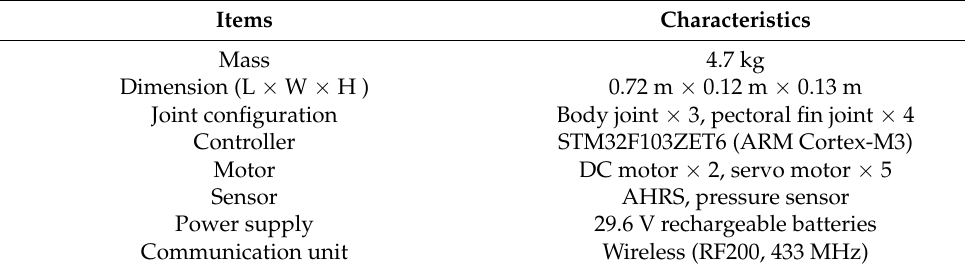
Figure 2. Prototype of the bionic robotic dolphin. Table 1. Technical specifications of the robotic dolphin